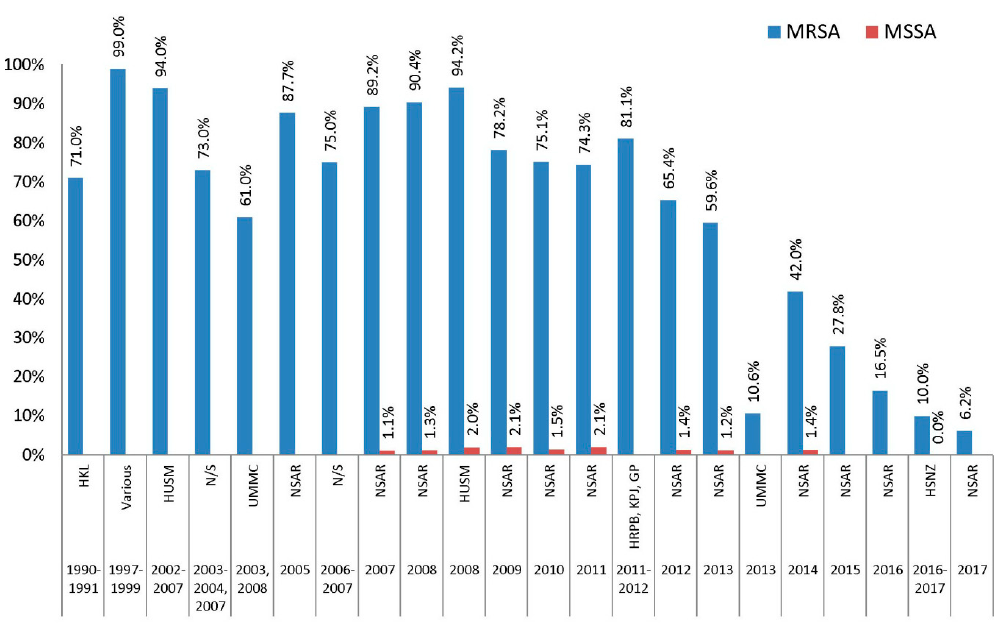
Figure 7. Prevalence of co-trimoxazole resistance in Malaysian S. aureus isolates, 1990–2017. Data from the NSAR reports; HKL between 1990 and 1991 [13]; various, collected from ten hospitals throughout Malaysia between 1997 and 1999 [14]; HUSM between 2002 and 2007 [15] and in 2008 [19]; not specified (N / S) between 2003 and 2004 and in 2007 [16], and between 2006 and 2007 [17]; UMMC in 2003 and 2008 [18], and in 2013 [22]; UKMMC in 2009 [20]; HRPB, KPJ and GP between 2011 and 2012 [21]; and HSNZ between 2016 and 2017 [23].